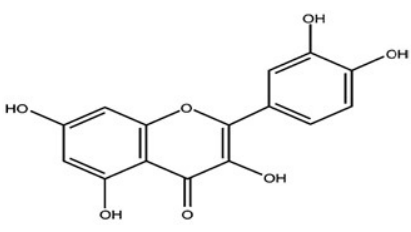
Figure 1. Structure of